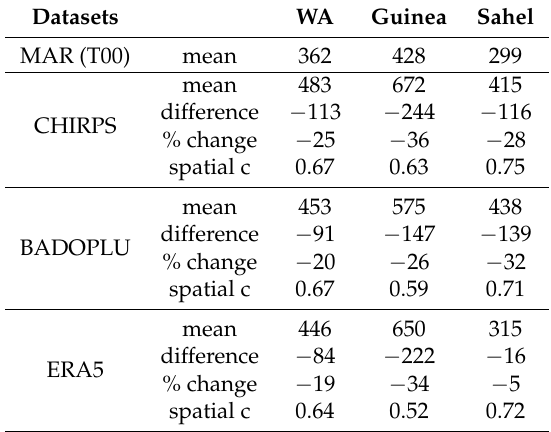
Table 1. Study period averages of JAS cumulative rainfall (mm) for MAR, CHIRPS, BADOPLU and ERA5. The model anomalies with respect to each comparative dataset are expressed in absolute and relative terms. The spatial correlation is calculated with a Spearman coefficient of correlation. Datasets WA Guinea Sahel MAR (T00) mean